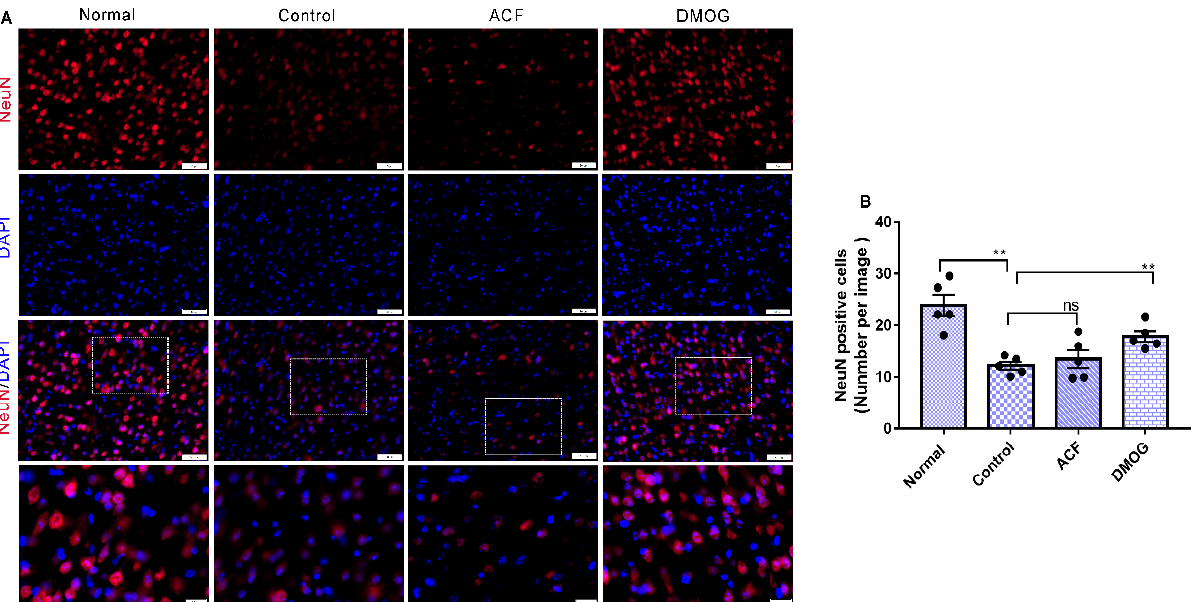
Figure 5. HIF-1 activation possesses a neuroprotective effect post-stroke. ( A ) NeuN immunostaining. ( B ) Number of NeuN positive cells post-stroke. Control vs. Normal; ** p < 0.01, ACF vs. Control; p = ns, DMOG vs. Control; ** p < 0.01. Scale bar 50 μ m and 20 μ m. All values are expressed as mean ± SEM, One-way ANOVA with post hoc Tukey test, n = 5.